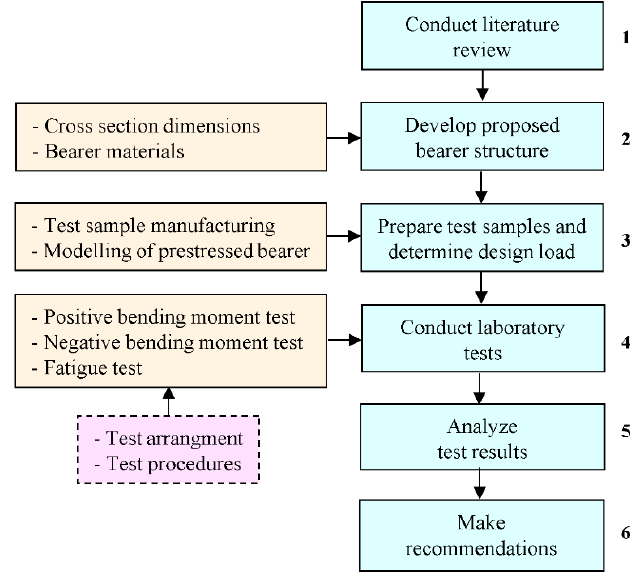
Figure 1. Study methodology.